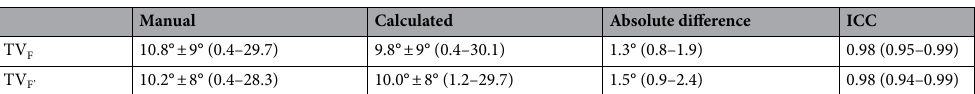
Table 2. The manually measured and calculated TV F and TV F’ are shown in degrees as mean ± SD (range). The absolute differences is demonstrated as median {interquartile range} due to a non-normal distribution. The intraclass correlation (ICC) is shown with the 95% confidence